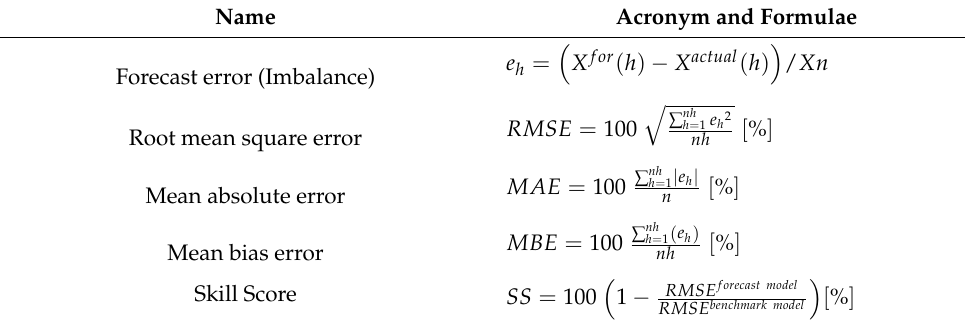
Table 2. Accuracy